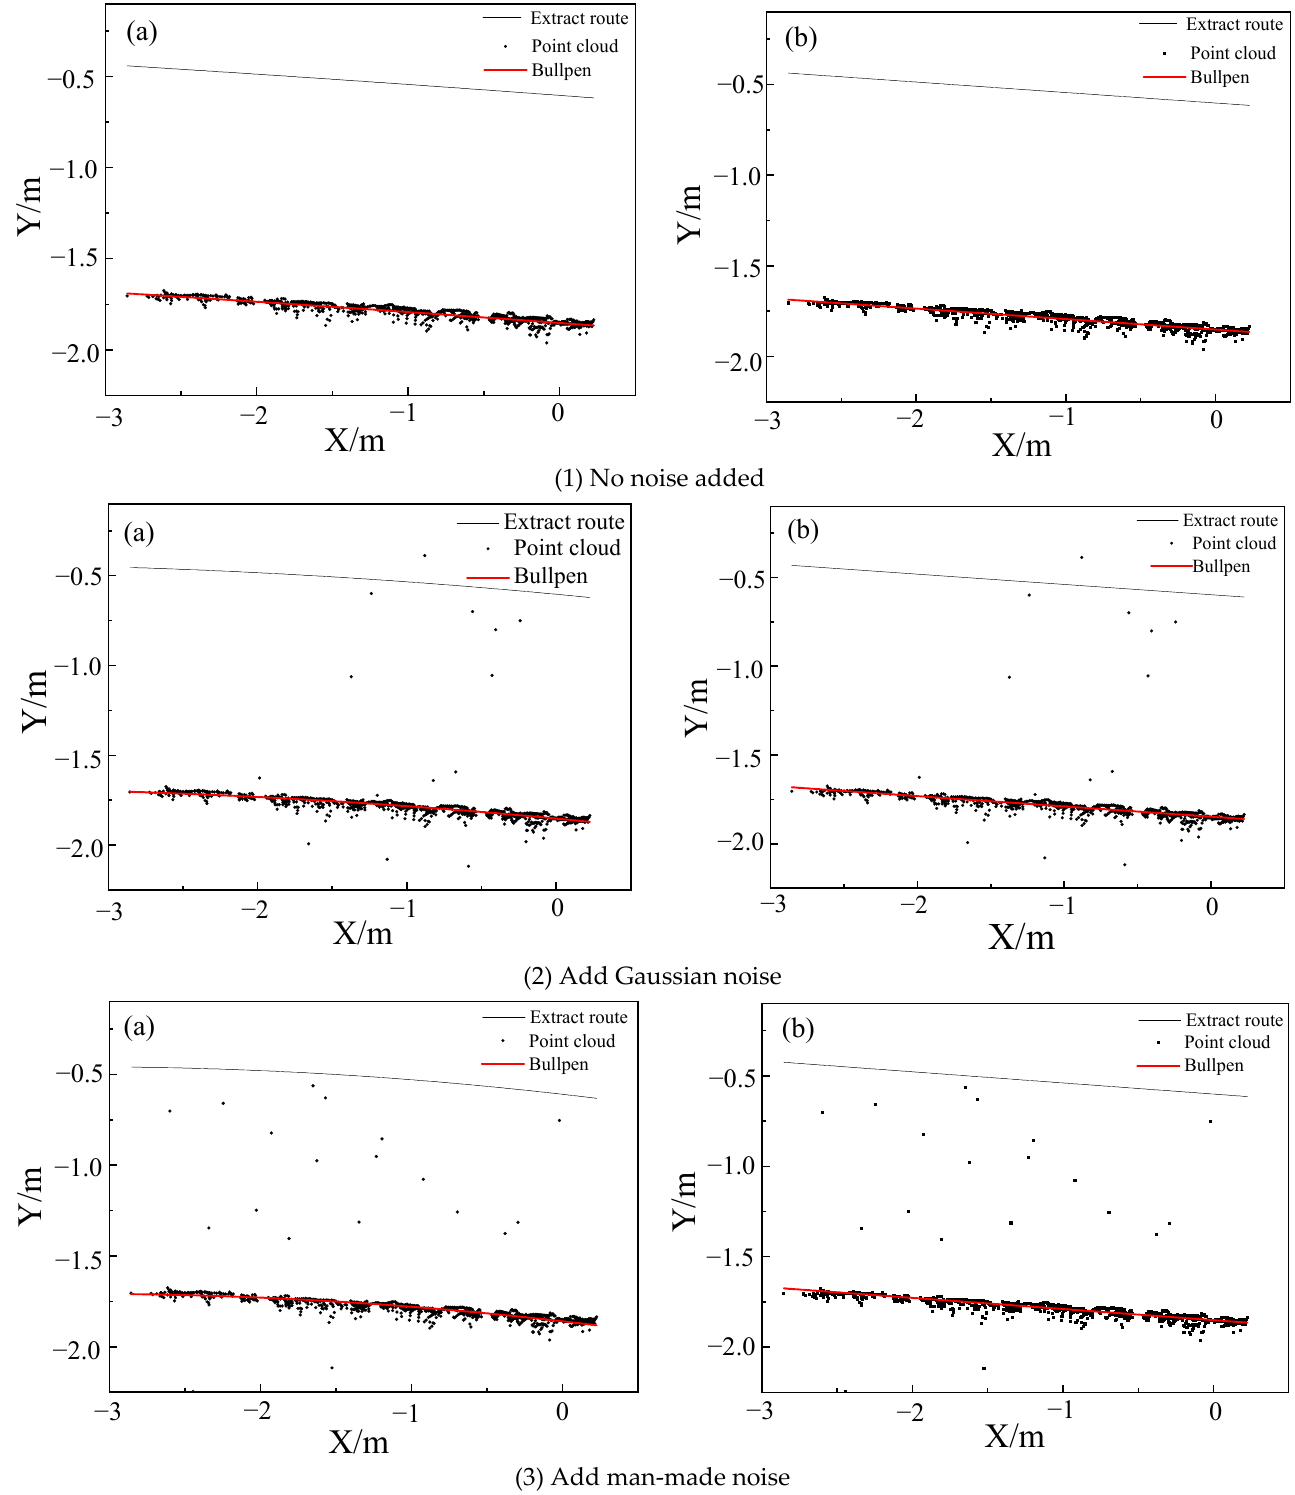
Figure 9. Results of extracted ridgeline and initial path by three methods under different noise. ( a ) Least squares method; ( b ) Random sampling consistency. Table 3. Extraction of bullpen line and initial path analysis by LSM and RANSAC.